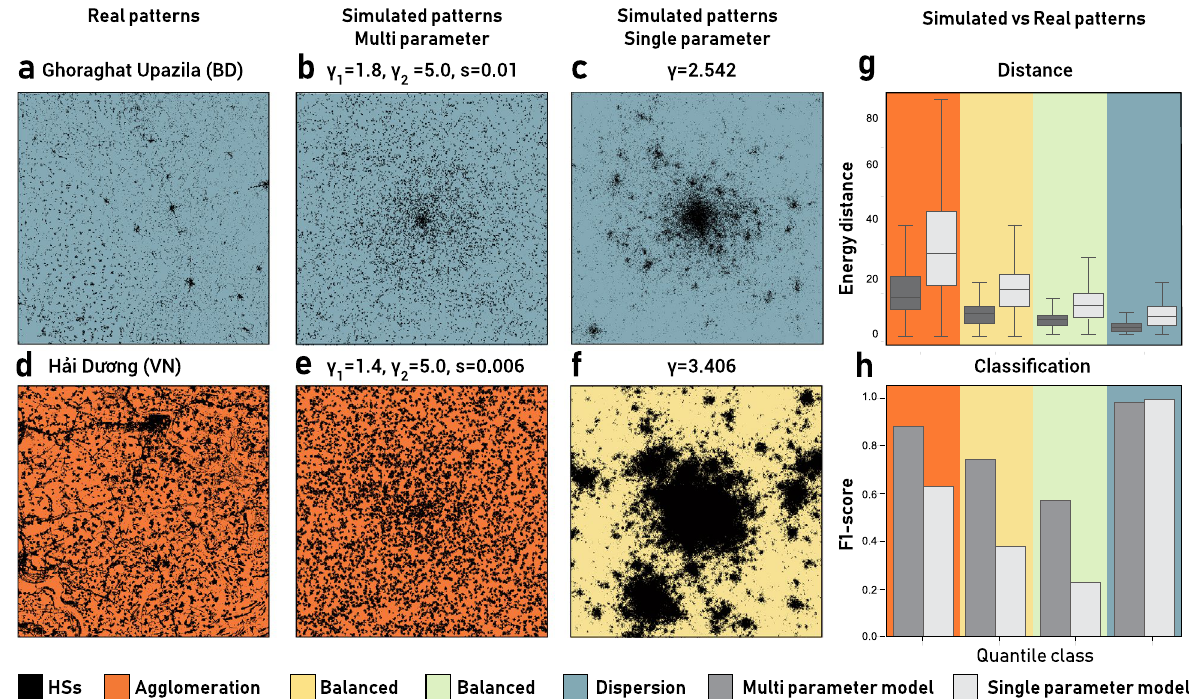
Figure 5. Qualitative and quantitative results of the proposed multi parameter model. ( a ) Area near Ghoraghat Upazila, Bangladesh, having a settlement pattern in the dispersion class; ( b ) the most similar simulation obtained with our model; ( c ) although the most similar simulation obtained with the single-parameter model lies in the same class as the real tile, it has a very different pattern. ( d ) Area near Hai Duong, Vietnam, having a settlement pattern in the agglomeration class; ( e ) the most similar simulation obtained with our model; ( f ) the most similar simulation obtained with the single-parameter model falls into the wrong class. ( g ) This box plot shows the energy distance between the real and simulated tiles computed for each class. It shows that our model always generates settlement patterns that are consistently better than those generated by the single-parameter model. ( h ) The F1-score obtained from the urbanization class of the real tile and the class of its most similar simulation for both our model and the single-parameter model. Our model outperforms the single-parameter model and generates settlement patterns compatible with the classes observed in the real